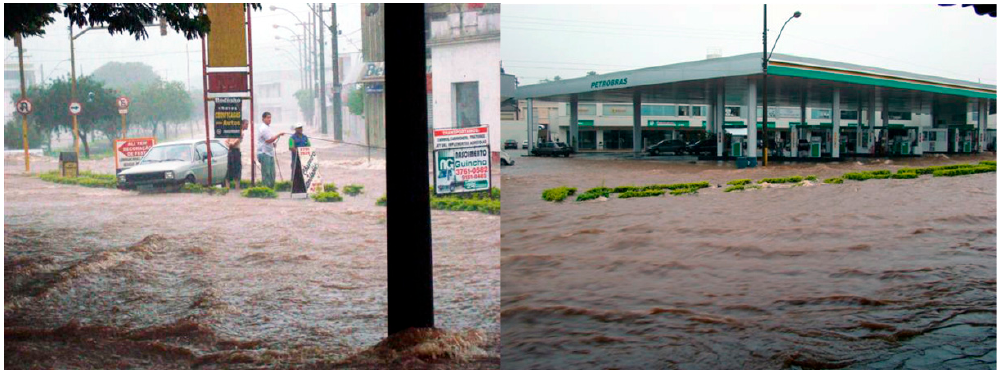
Figure 3. Illustration of 29 January 2008 severe flood in the Batatais town.